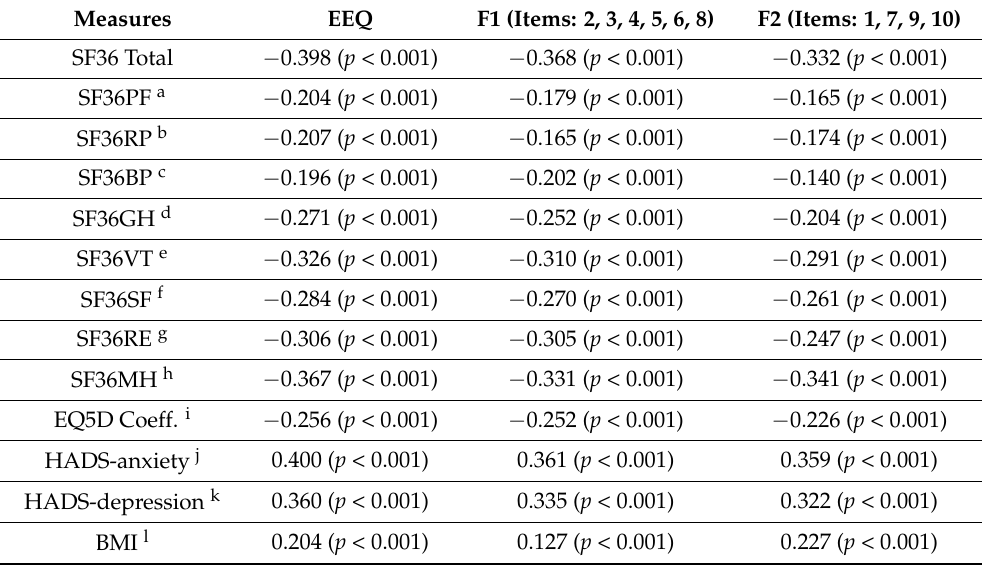
Table 3. Spearman correlation coefficients between EEQ and measures used for convergent validity.